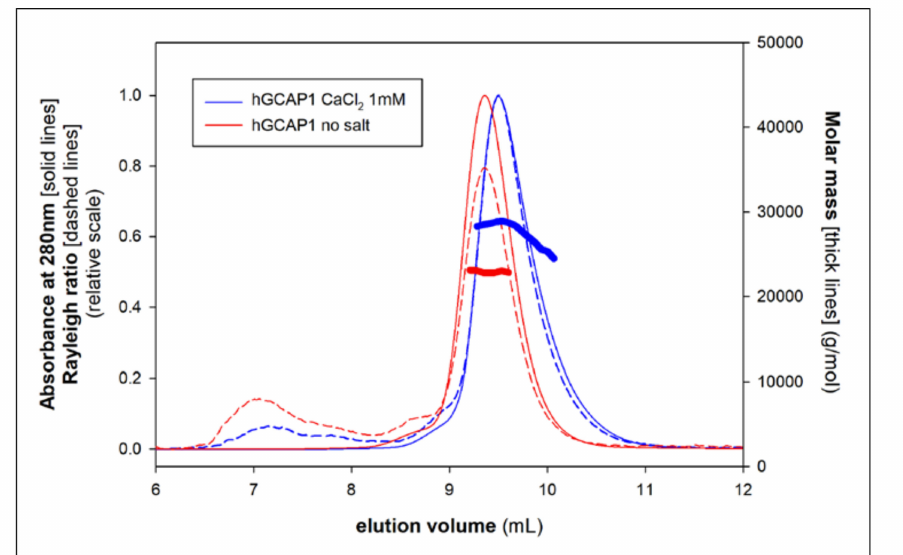
Figure 3. Multi-angle light scattering coupled with SEC (SEC-MALS) of hGCAP1 in the salt-free bu ff er. Without salt hGCAP1 is monomeric (Mw 23 kDa; red curves) and it moves toward the monomer-dimer equilibrium upon the addition of 1 mM Ca + 2 (Mw ~ 29 kDa, blue curves). The thick lines represent the molar mass measured by MALS (legend on the right) in correspondence to each SEC peak (solid lines; legend on the left); the dashed lines represent the scattering signal (legend on the